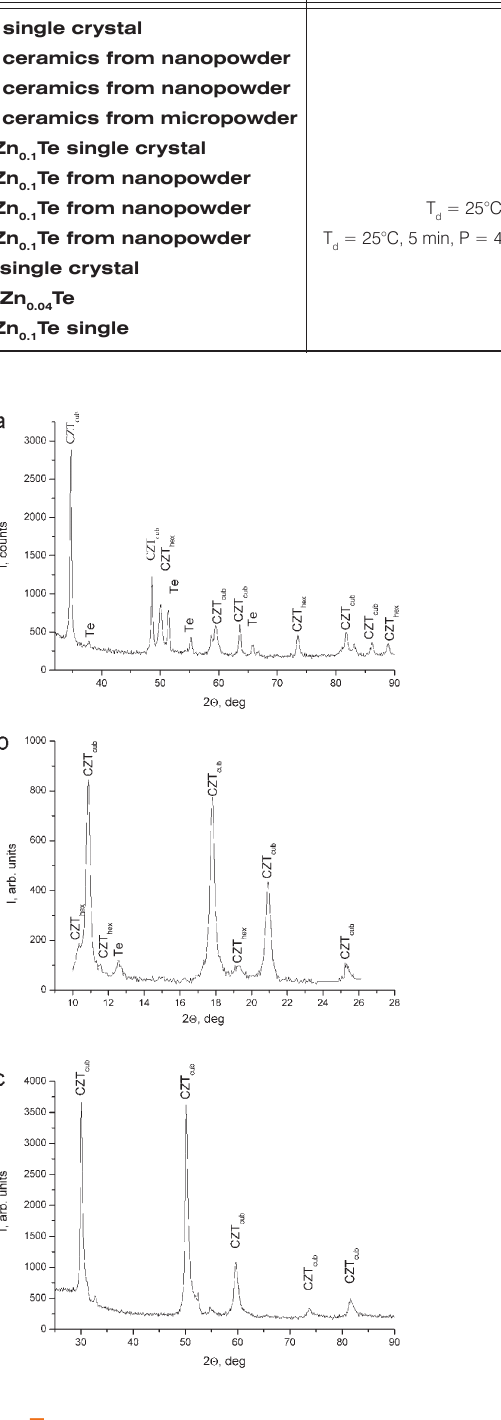
Figure 7. Difftactograms of CZT: (a) nanopowder; (b) ceramics produced by compaction of the powder at T = 25°C, p = 450 MPa; (c) ceramics annealed at T = 300°C for t = 2